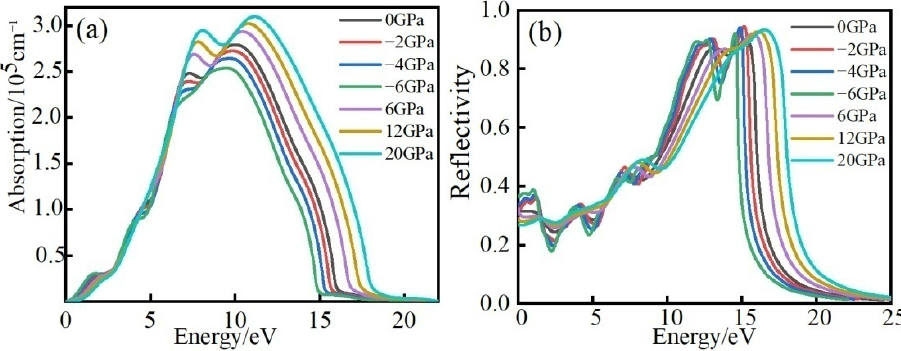
Figure 7. Absorption and reflection spectra for ( a ) the absorption spectrum and ( b ) the reflection